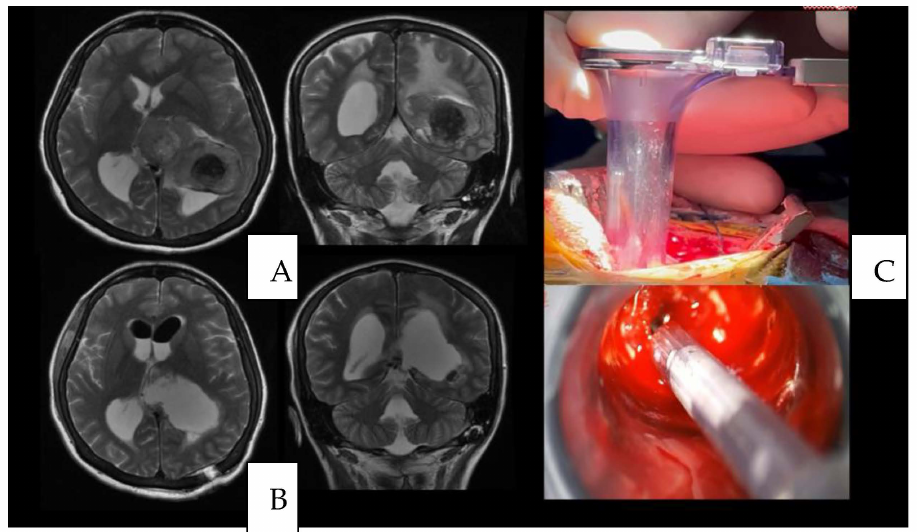
Figure 3. ( A ) Axial and coronal view of a preoperative T2 weighted MRI; ( B ) the postoperative axial and coronal view of a preoperative T2 weighted MRI that documents the GTR; ( C ) an intraoperative use of the tubular retractor.